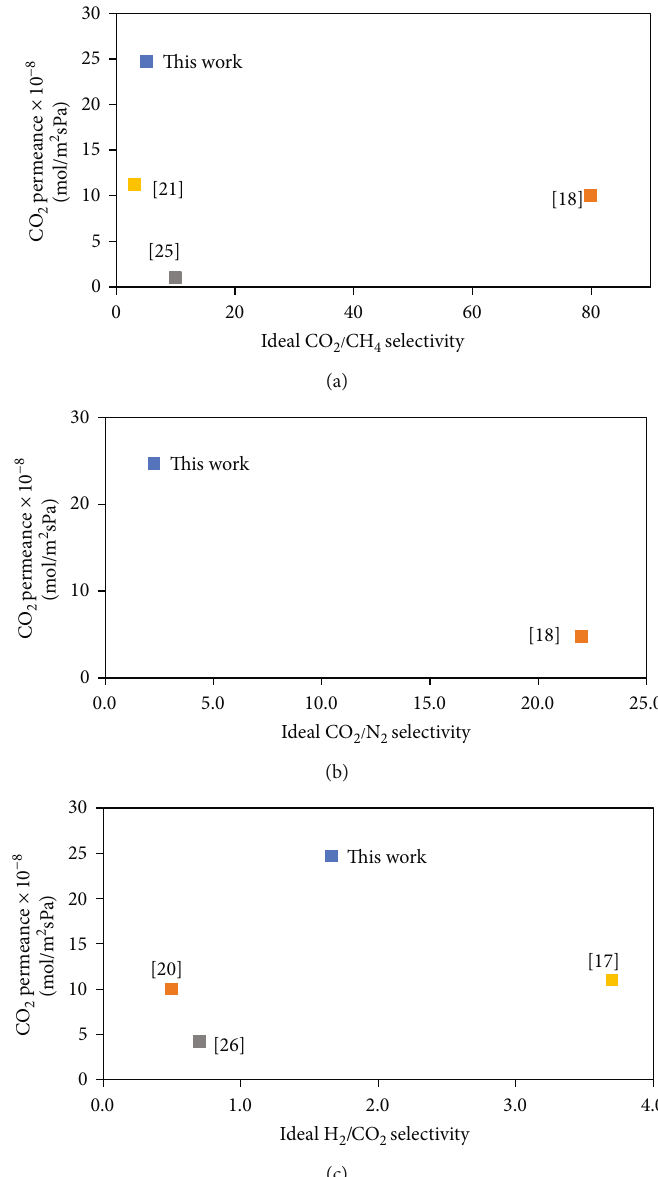
Figure 5: Comparison of gas pair ideal selectivities with reported literature ((a) CO